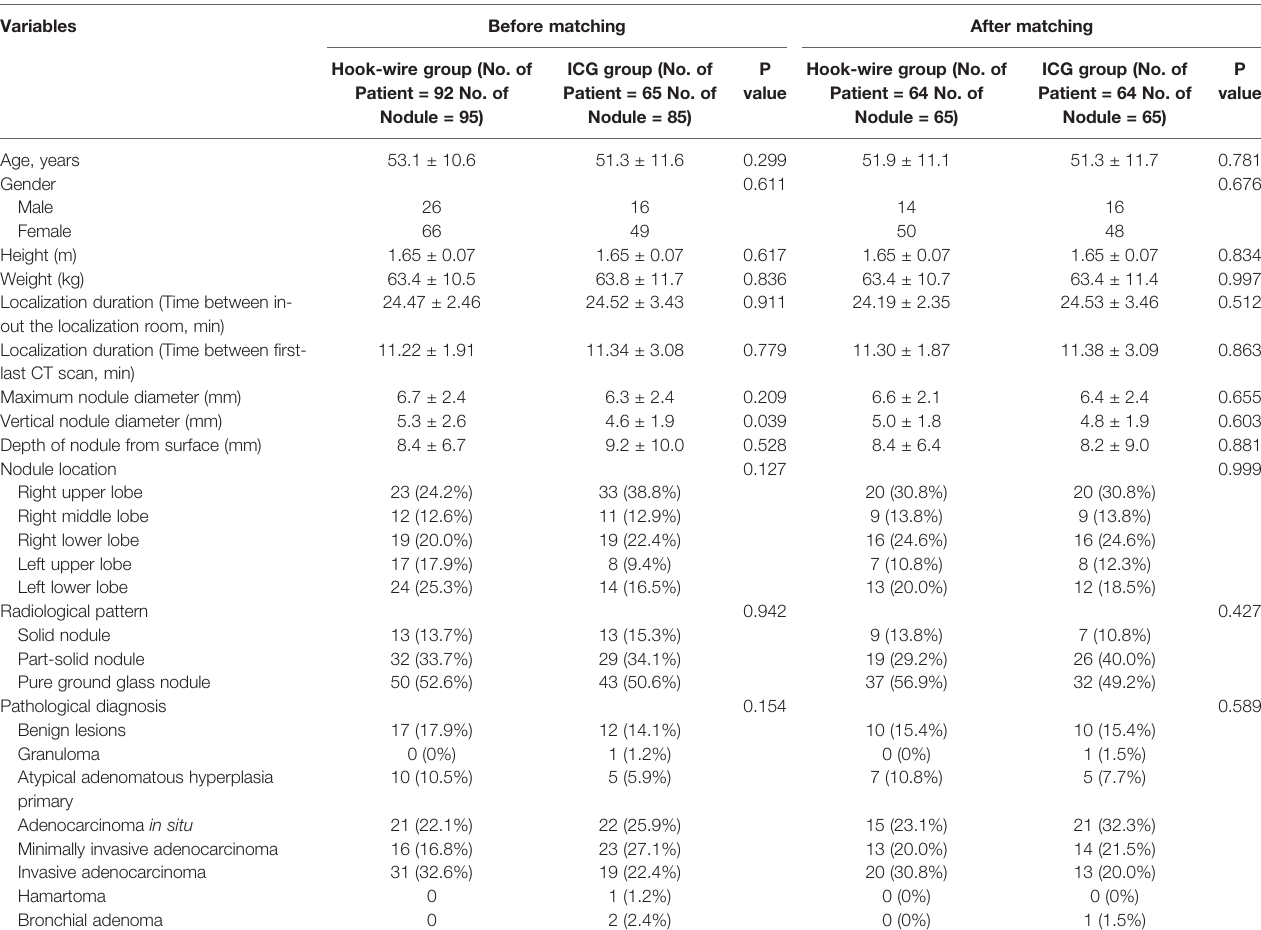
TABLE 1 | Patients ’ characteristics and detailed tumor parameters for both groups. Variables Before